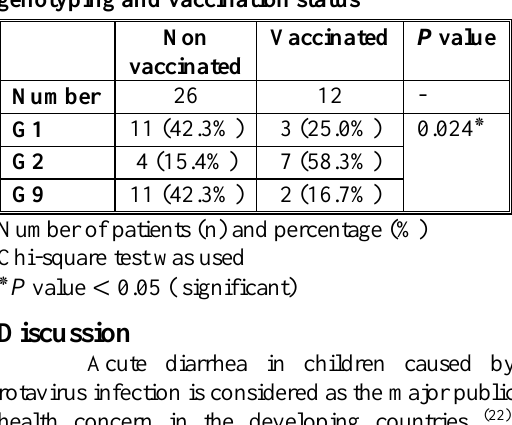
Table 9. Association between rotavirus genotyping and vaccination status